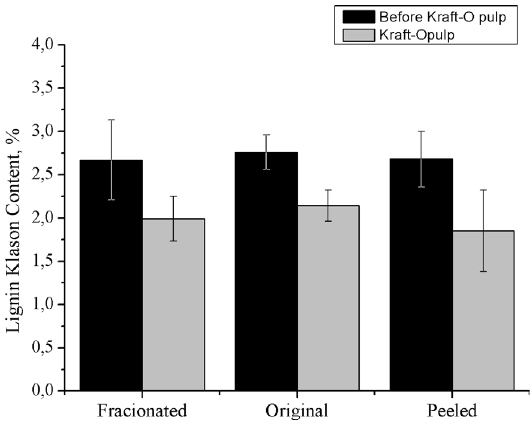
Figure 1. Lignin Klason content in the original and treated pulps.